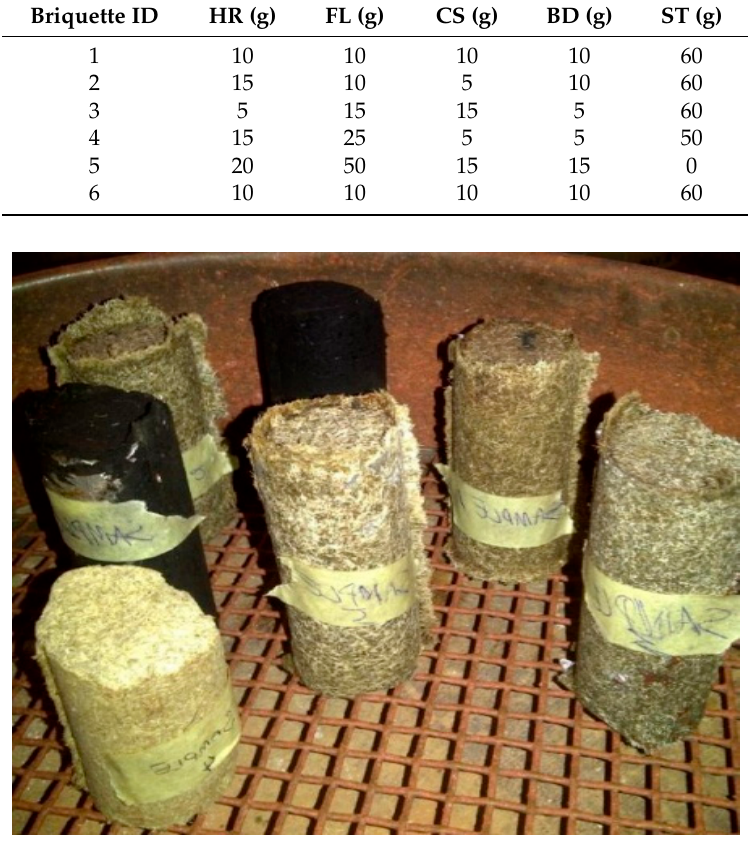
Figure 3 . Briquettes from Tannery Solid Waste. Figure 3. Briquettes from Tannery Solid Waste.